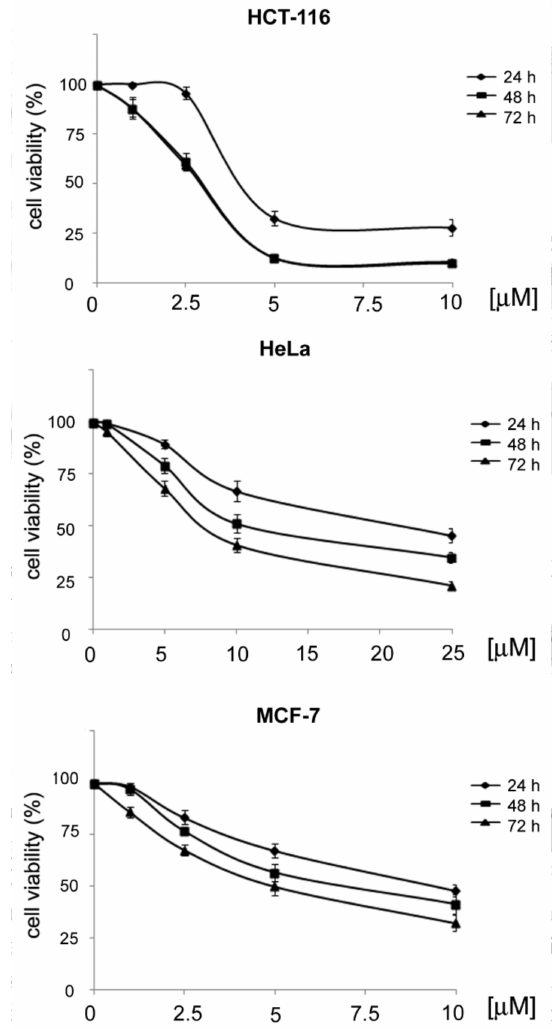
Figure 7. Effects of 28 on the viability of HCT-116, HeLa, and MCF-7 cells. The cells were treated with 28 in the concentration range of 1–25 µ M. After 24, 48, and 72 h of incubation, cell viability was assessed with the MTT assay. Values represent mean ± SD of three independent